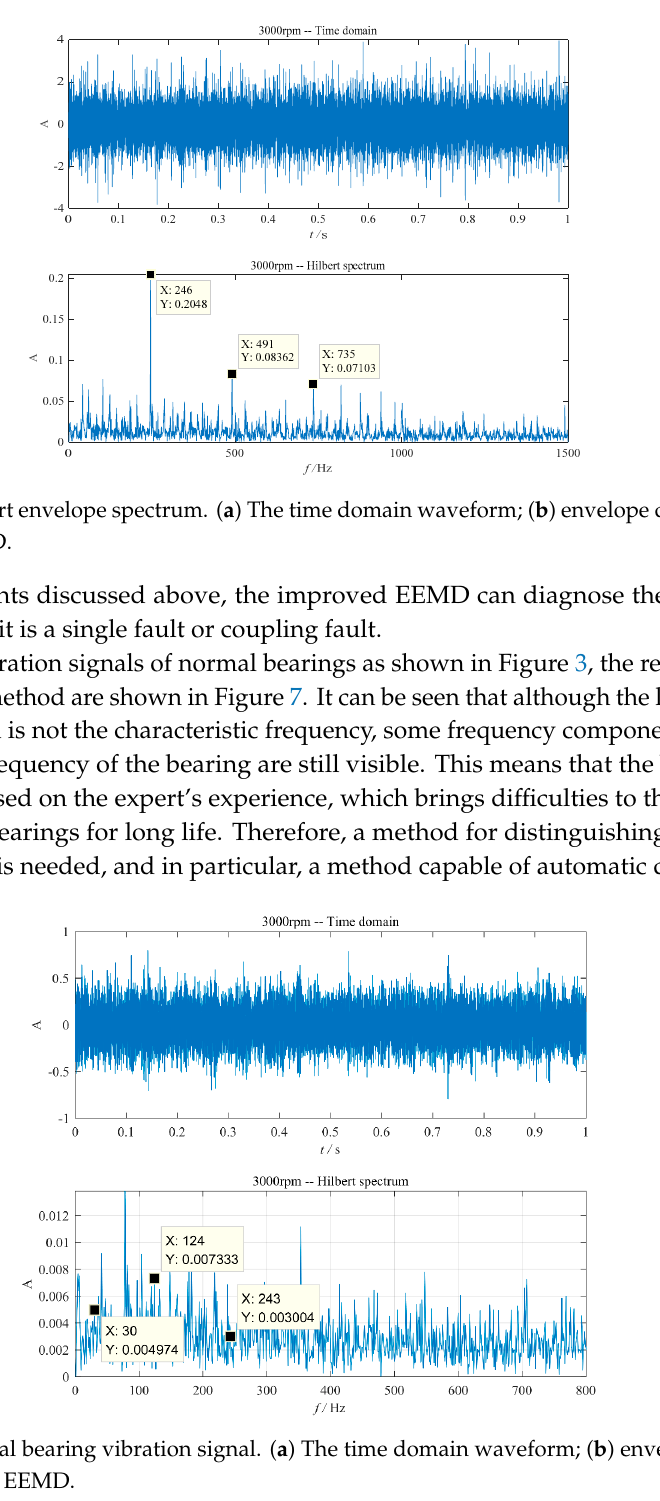
based on improved